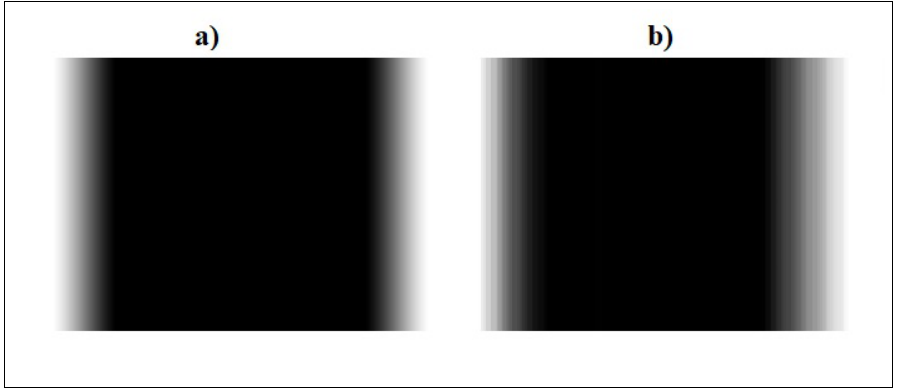
Figure 1. Example of the results of an image submitted to the compression process during transfer by a message transfer application: ( a ) original transferred image and ( b ) received image result with